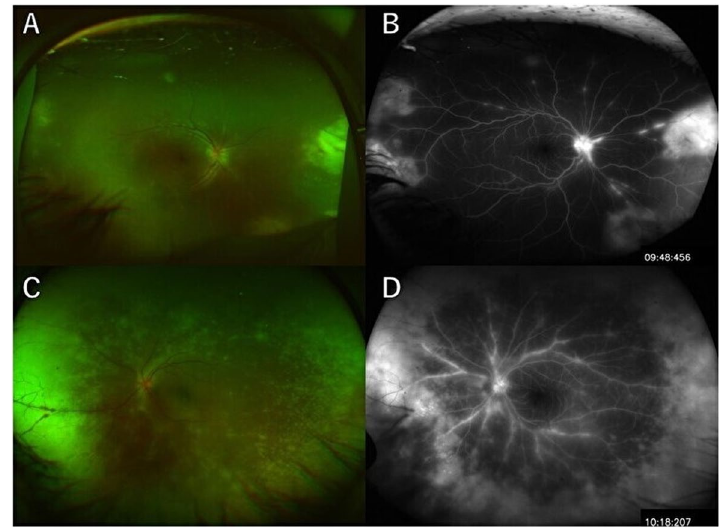
Fig. 1 Fundus photograph shows swelling of the optic disc, yellowish-white retinal lesions with discrete borders, and retinal vasculitis in the right eye of Case 1 at the time of the first visit ( A ). Fluorescein angiography (FAG)shows leakage due to vasculitis but no nonperfusion area is seen ( B ). Fundus photograph shows swelling of the optic disc and beaded expansion of retinal blood vessels ( C ). FAG shows leakage due to vasculitis and peripheral retinal strong leakage like a frost covered tree is seen ( D